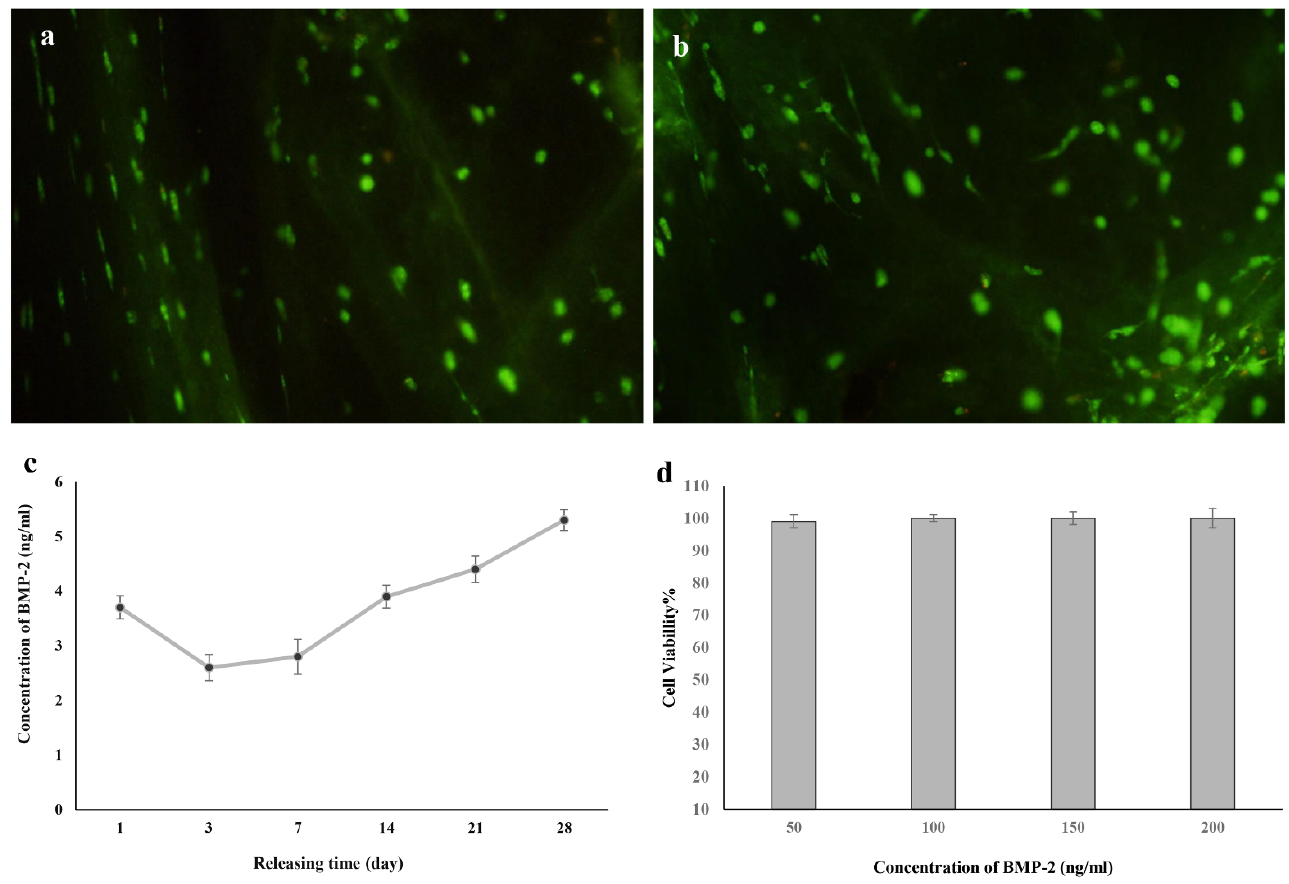
Figure 4. Fluorescence microscopic images of C-EnSCs in fibrin gel showing green staining for viable cells with 100 ng/mL concentration of BMP-2 (10X). ( a ) After 1 day ( b ). After 3 days. ( c ) Release of BMP-2 from fibrin gel. Amount of BMP-2 release per time point is graphed. ( d ) Results of the viability percentage of C-EnSCs using MTT 24 h after BMP-2 treatment. At concentrations of 50, 100, 150, and 200 ng/mL, the viability of C-EnSCs was 99–100% in all concentrations.